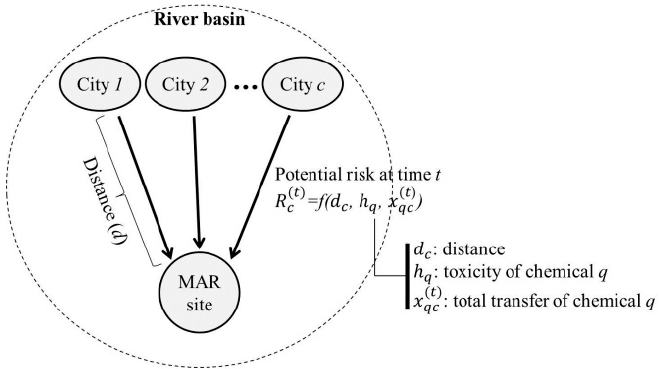
Figure 4. Potential risks from cities to a MAR site.